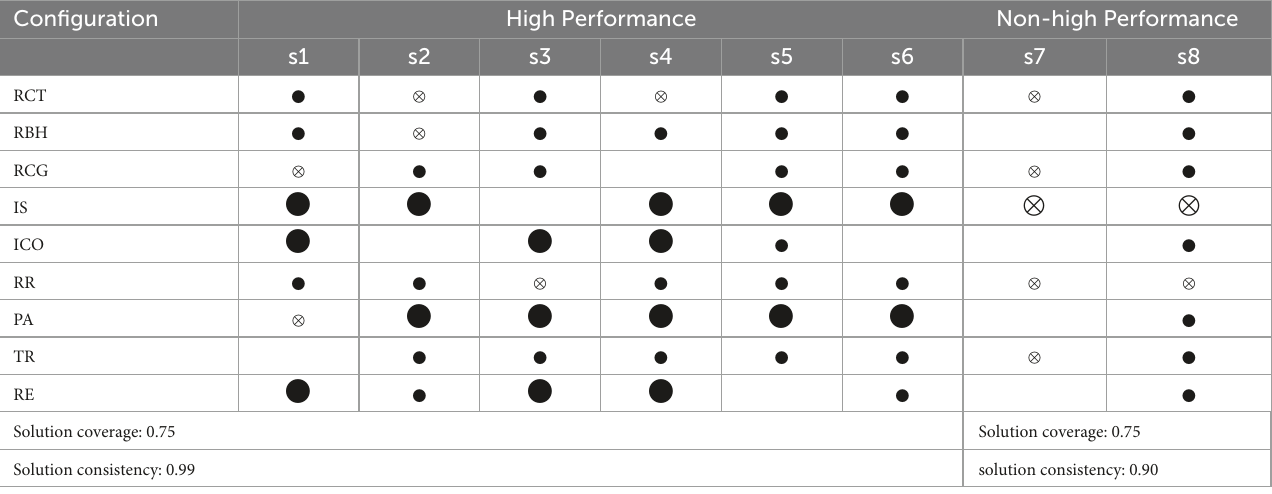
TABLE 5 Configurations of enterprise resilience capabilities and human resource management (HRM) practices for high-performing enterprises and non-high performing enterprises. Configuration